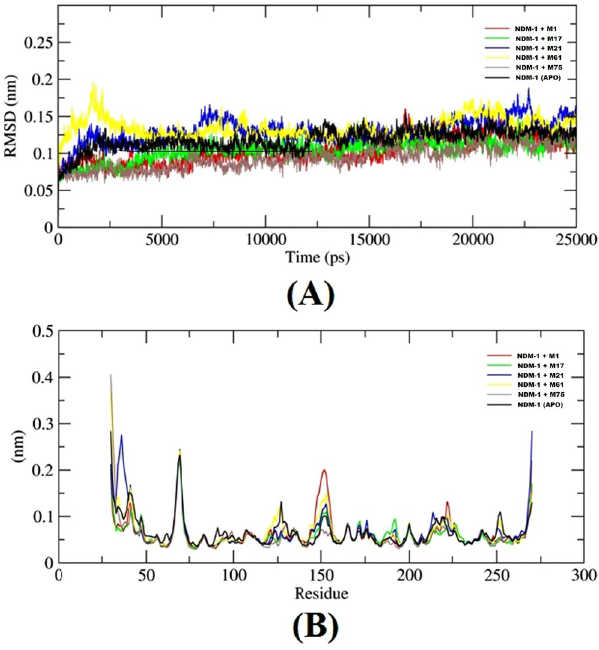
Figure 2. ( A ) RMSD analyses of NDM-1 complexes and ( B ) RMSF analyses of NDM-1